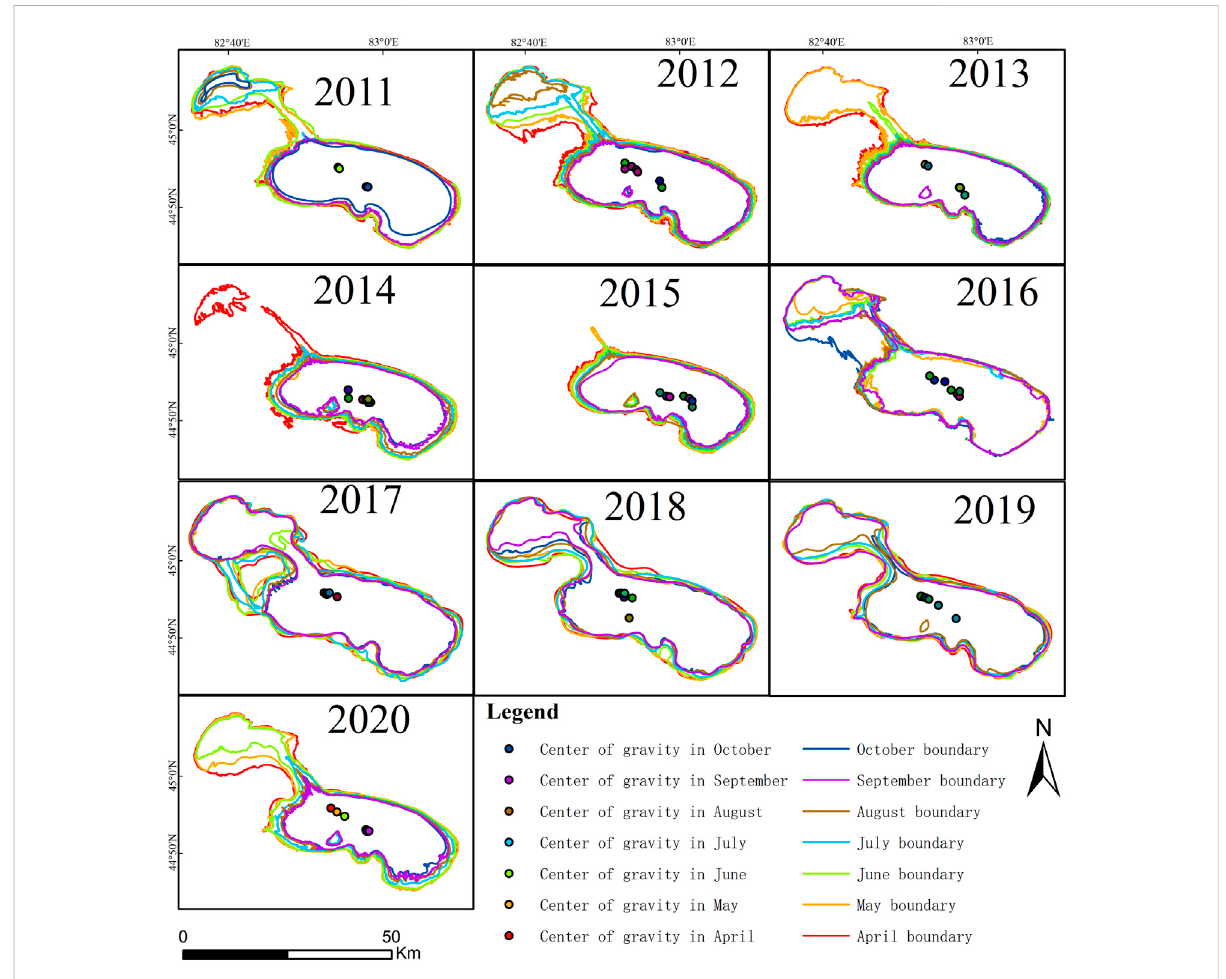
FIGURE 8 Center of gravity shift trajectory of Ebinur Lake from 2011 to